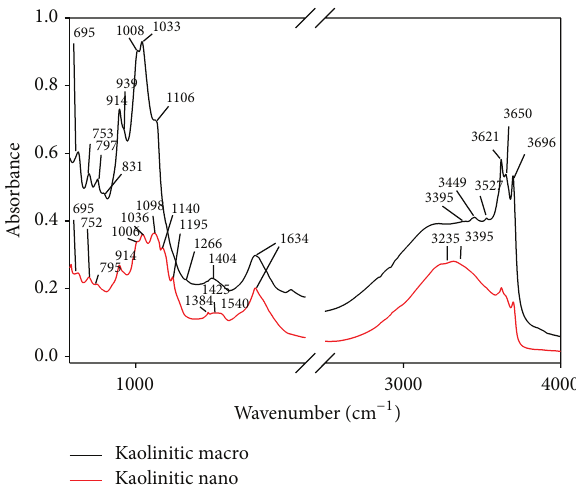
Figure 6: Smectitic nano- and macrocolloid FTIR characterization.